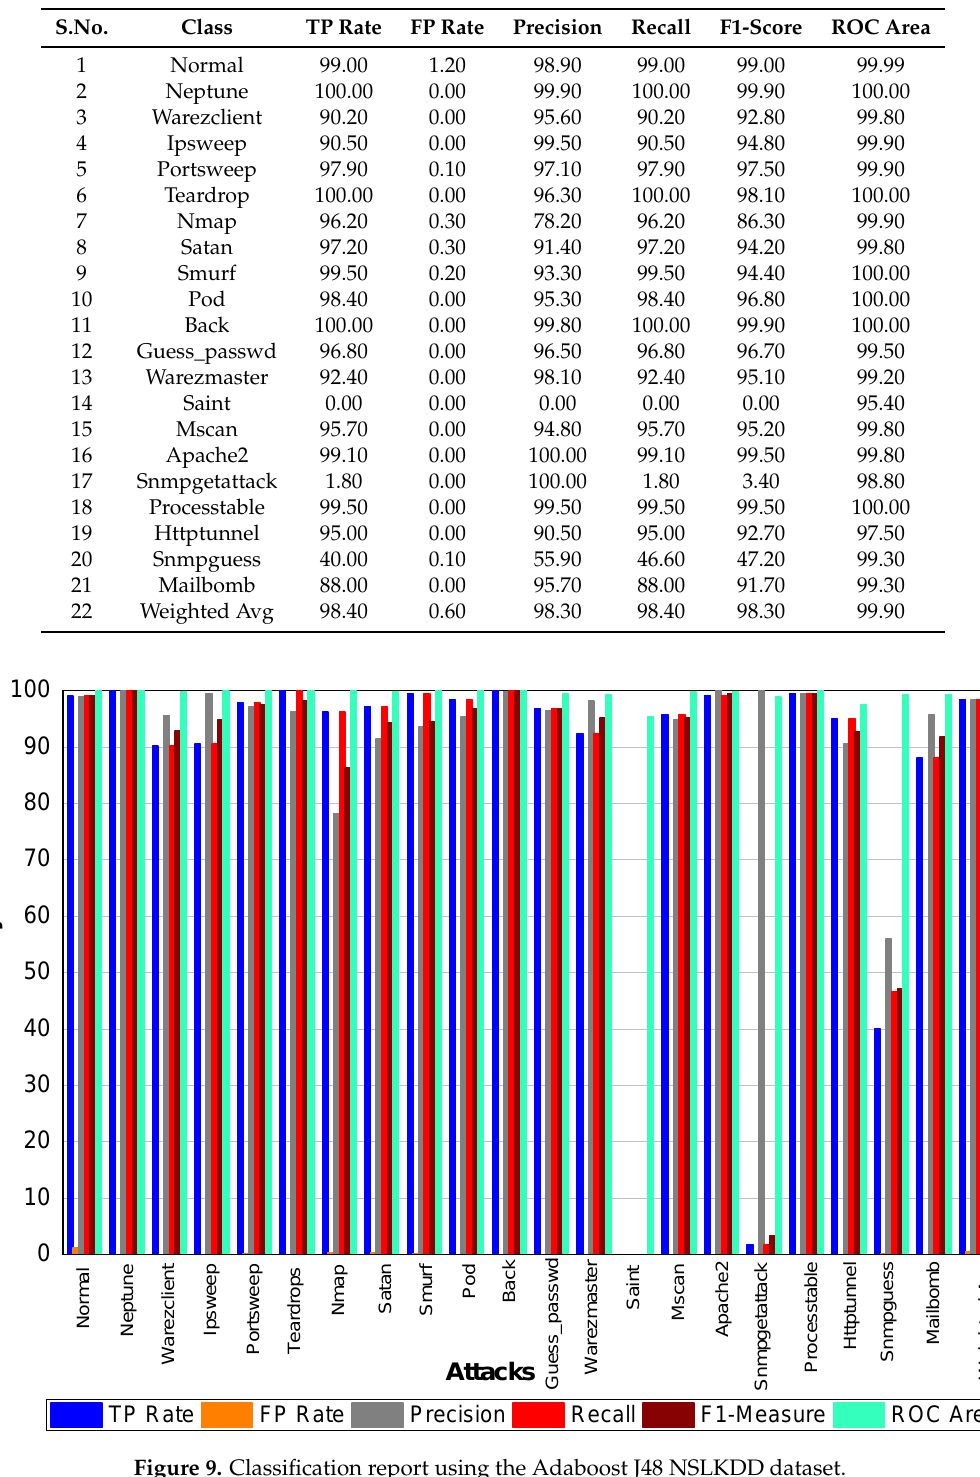
Table 39. Multiclass classification report for NSLKDD using Adaboost J48.